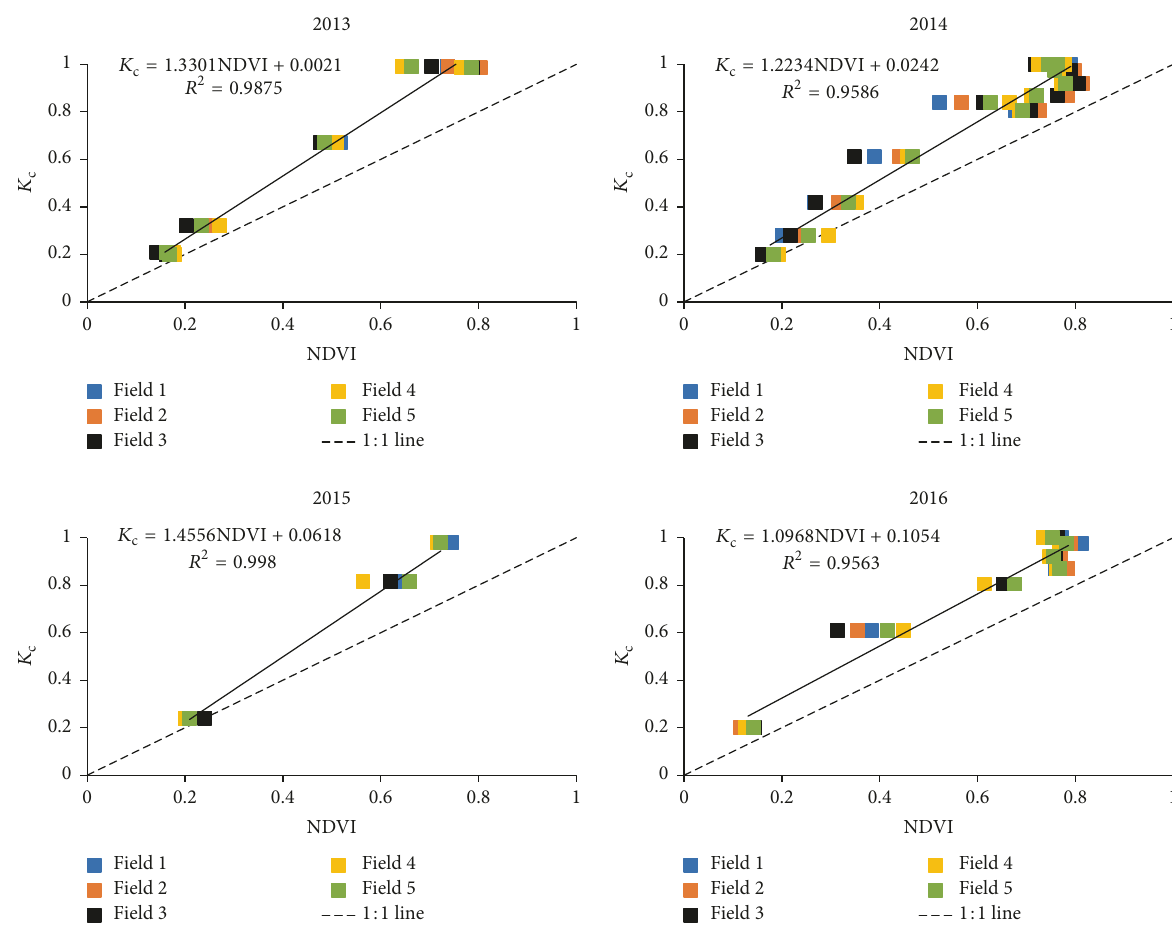
Figure 4: Linear relationship between NDVI derived from NDVI maps and 𝐾 c from ASCE Manual 70 for four growing seasons. The dashed line indicates the 1: 1 line.